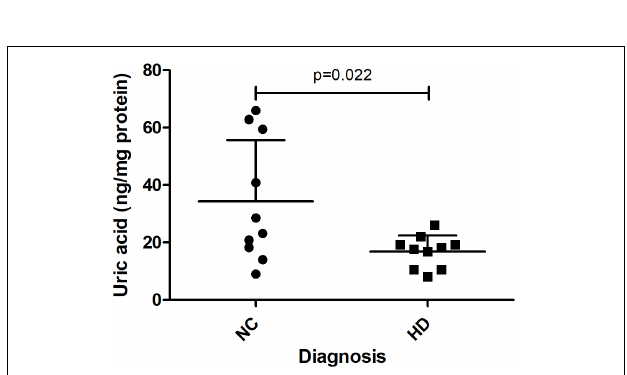
FIGURE 6 | Uric acid (UA) levels in postmortem prefrontal cortex from Huntington’s disease (HD) subjects and matched controls. UA levels, corrected for total protein, were measured in prefrontal cortical samples from n = 10 HD patients and n = 10 matched normal controls (NC). Data points reflect mean + SD. Difference in UA concentrations in HD versus normal controls was determined using Student’s t -test (unpaired, two-tailed), p =